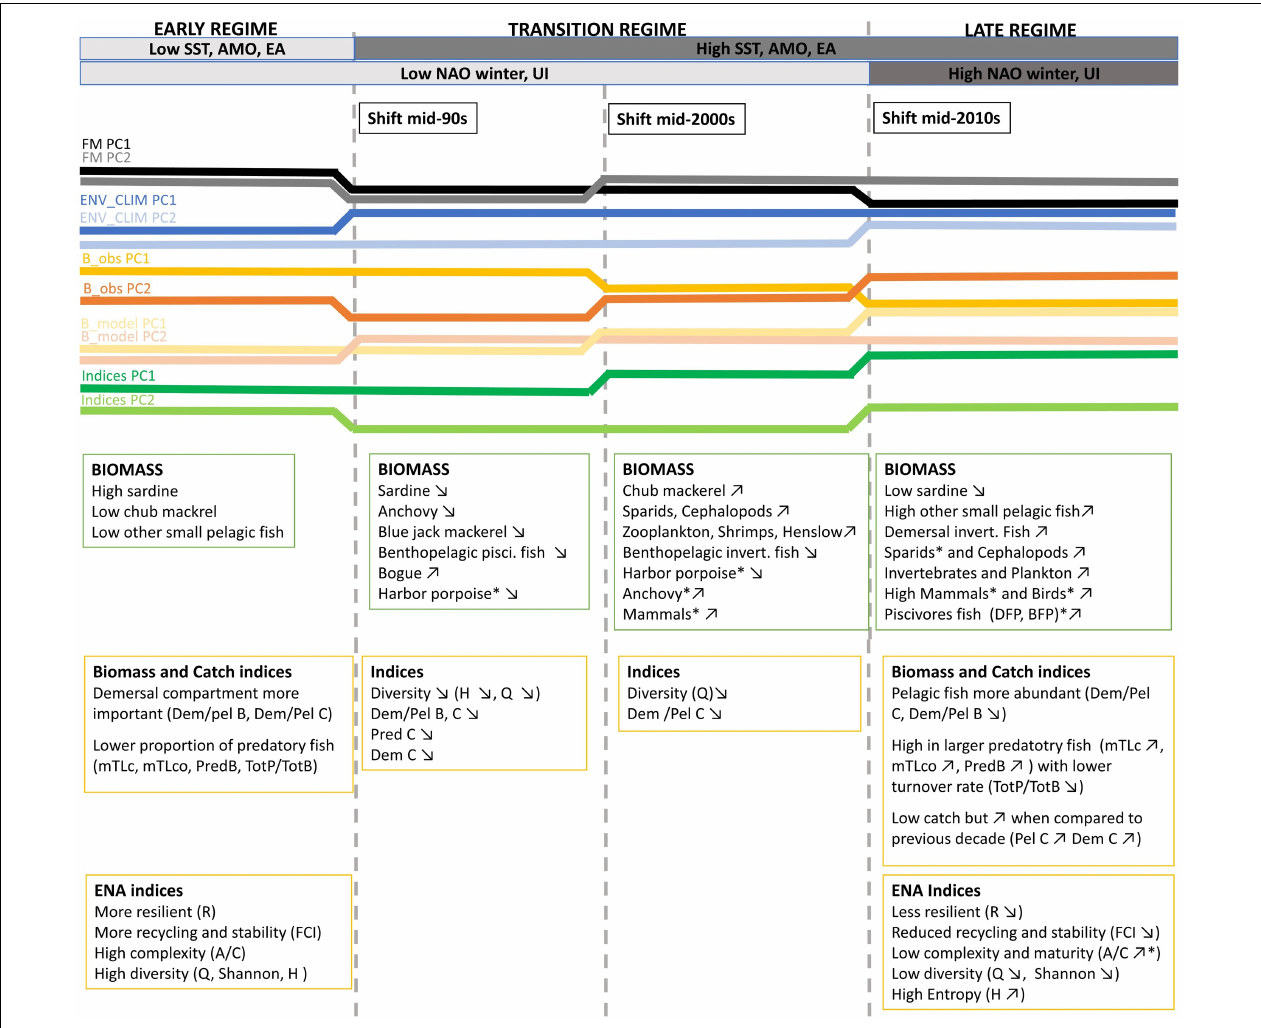
FIGURE 9 | A conceptual diagram displaying the changes in the Portuguese continental shelf ecosystem (PCSE) between 1986 and 2017. Variable names marked by * means that for time series representing this variable shift was detected at p ≤ 0.1 significance level. For the remaining variables, shifts were detected at p ≤ 0.05. Detailed information about detected shifts that were summarised in the conceptual diagram is presented in Figure 5 and Supplementary Table 4 . Abbreviations, used in the figure, are explained in Supplementary Table 4